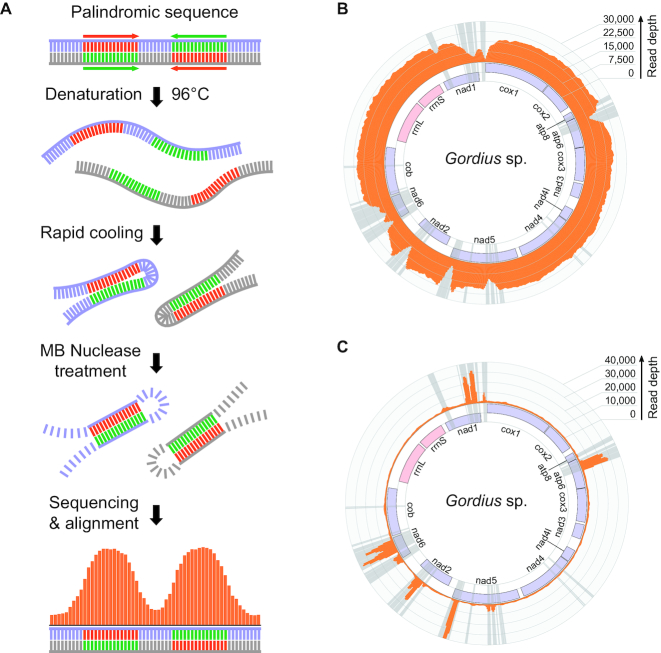
Inverted repeat enrichment experiment with the mitochondrial DNA of Nematomorpha. (A) The DNA digestion procedure employed for confirming the inverted repeat sequences, involving DNA denaturation, rapid renaturation, and treatment with a single-strand-specific mung bean nuclease. (B) Histogram of read depth over the mitochondrial genome of Gordius sp. with reads from a sequencing library of untreated DNA; inverted repeat regions are depicted in gray. (C) Mapping of reads from a library of nuclease-treated DNA, showing the enrichment of inverted repeat sequences.